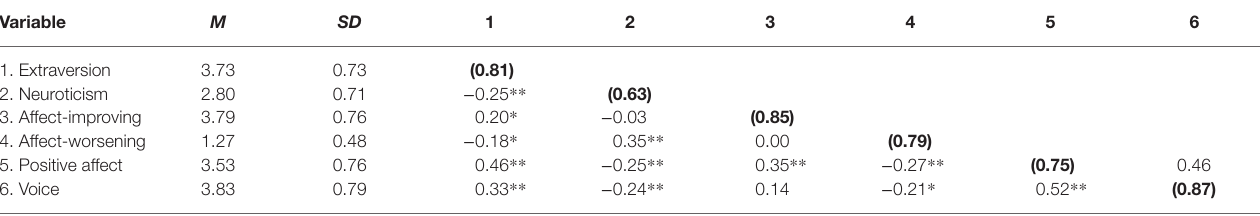
N between-subjects = 124–125, N between-within = 399–404. Between-subjects correlations are lower the diagonal, within-subject correlations are upper the diagonal. Reliabilities are in bold and displayed in parentheses in the diagonal. * p < 0.05, ** p < 0.01.